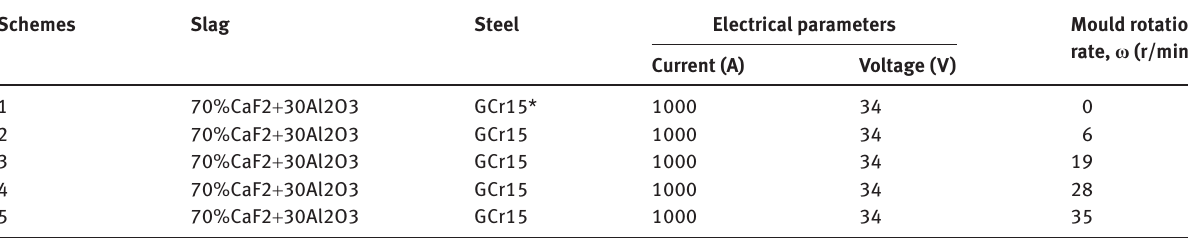
Table 1: Experimental